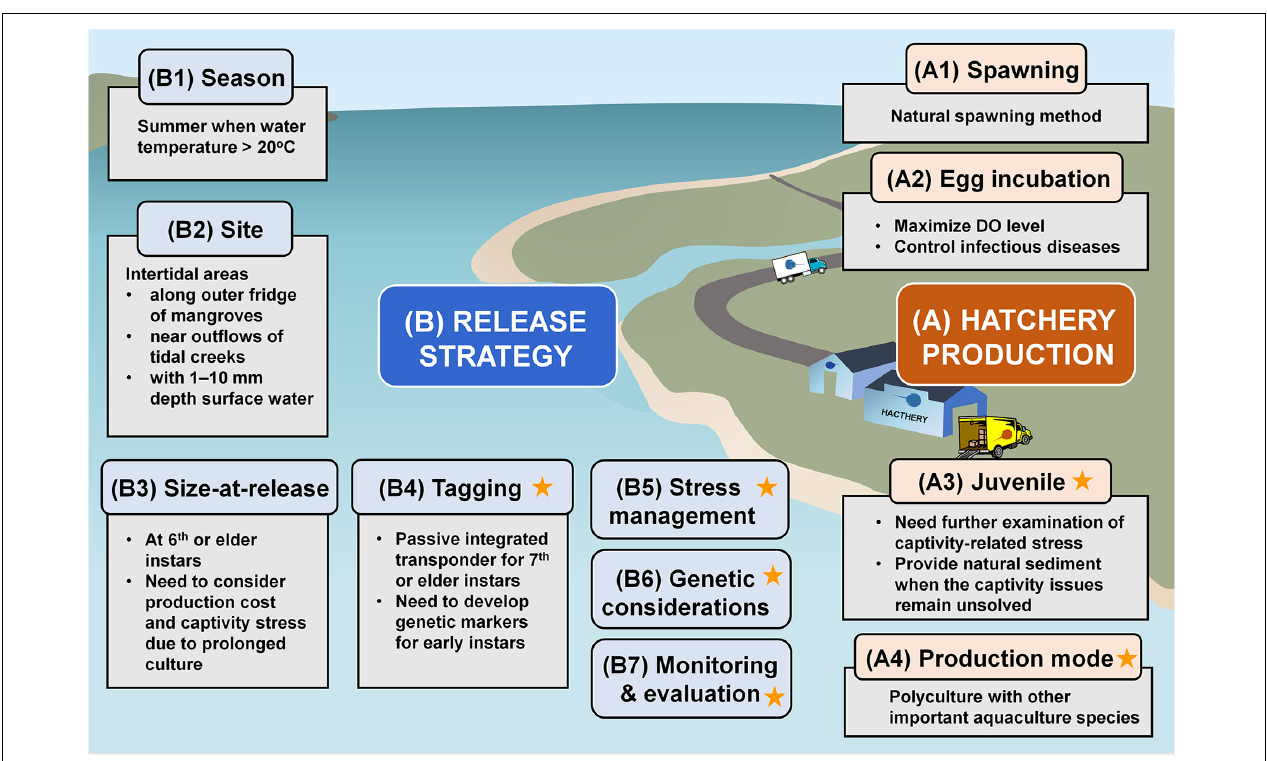
FIGURE 3 | Technical framework for developing the responsible stock enhancement programs for T. tridentatus conservation. The star symbols indicate the research gaps which should be focused in future studies. The sources of information are summarized in Supplementary Table 2 .